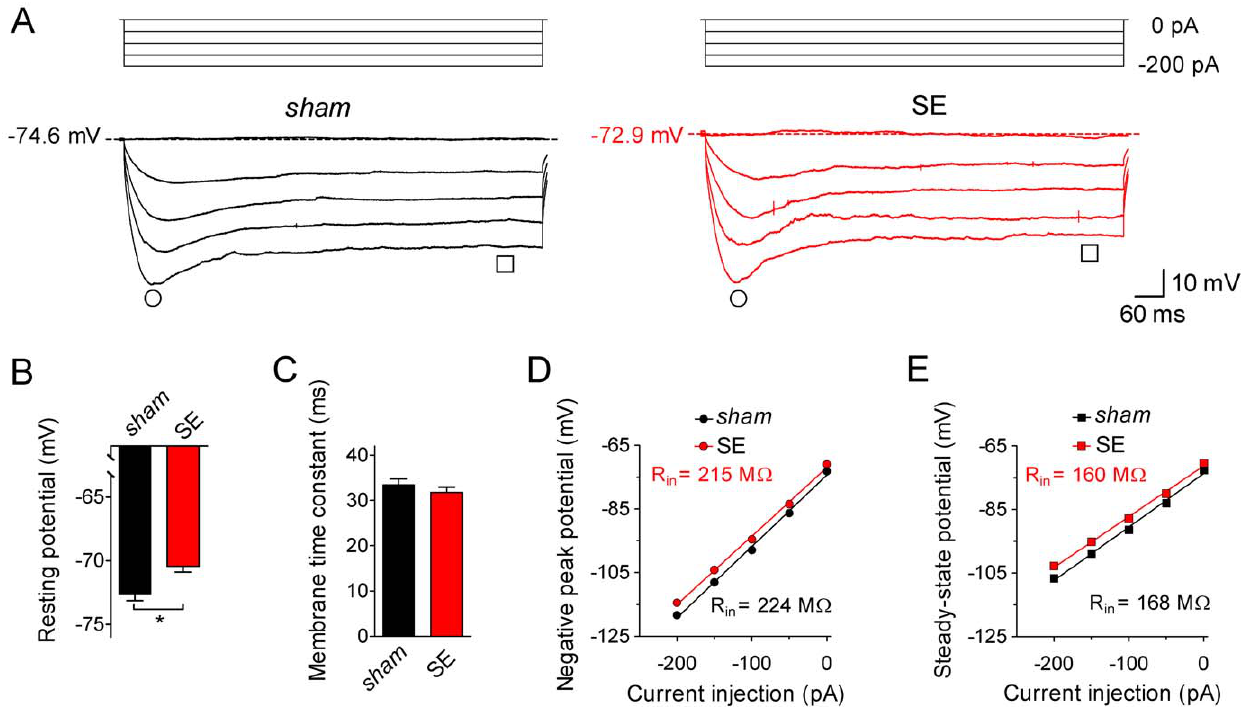
Figure 2. Subthreshold electrophysiological properties of CA1 pyramidal cells. Individual CA1 pyramidal cells in a hippocampal slice preparation were electrophysiologically characterized in the whole-cell patch-clamp configuration. A . Current-clamp recordings (test pulses of 0 to 2 200 pA for 900 ms as indicated) obtained from a CA1 pyramidal cell of a sham -treated animal ( sham , black traces on the left) and from a CA1 pyramidal cell of a kainate-injected animal with SE behavior (SE, red traces on the right). Note that the potential measured with 0 pA current injection is slightly less negative in the SE cell. Time points for the measurement of negative peak potential (circles) and steady-state potential (squares) are indicated. B . Resting potential of sham (black bar, n=65) and SE cells (red bar, n=81); * p , 0.05). C . Membrane time constant (obtained with a single- exponential fit to the initial voltage deflection in response to a 2 50 pA current injection) of sham (black bar, n=65) and SE cells (red bar, n=81). D . Negative peak potential (see circles in A) plotted against current injection for sham (black, n=65) and SE cells (red, n=81). E . Steady-state potential (see squares in A) plotted against current injection for sham (black, n=65) and SE cells (red, n=81); error bars in D and E are smaller than symbols; linear fits to the data yielded slopes from which input resistance (R in ) was determined (numbers are mean